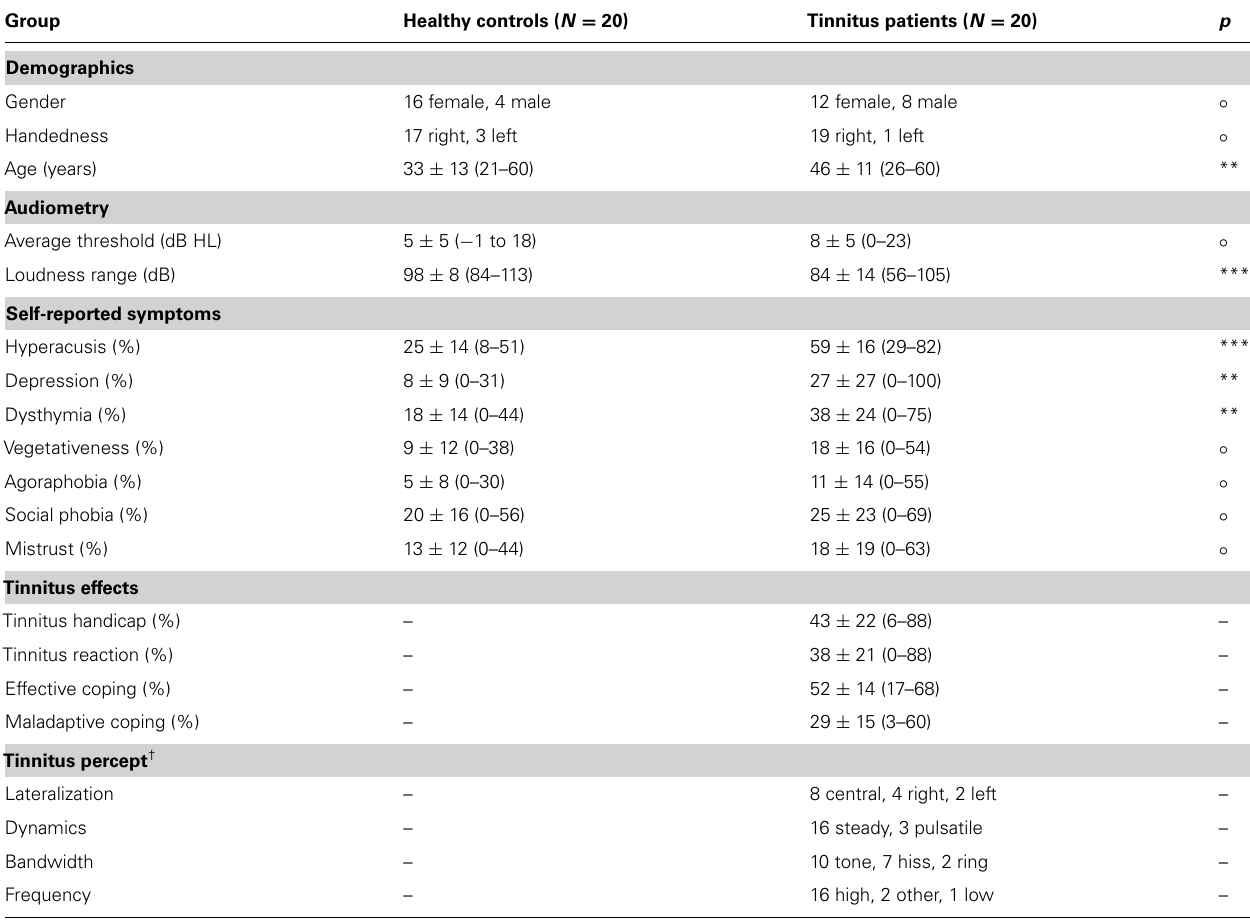
Table 1 | Comparison of subject characteristics between the two subject